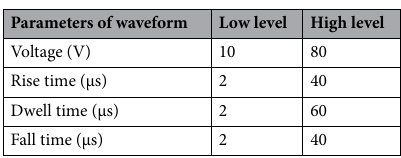
Table 2. Ranges of each parameter in